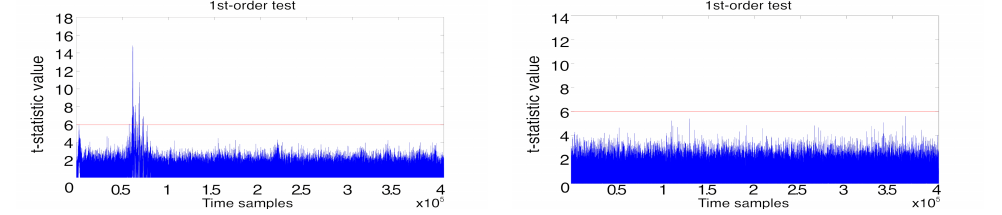
Figure 11: rdm_point () random vs fixed in- put point